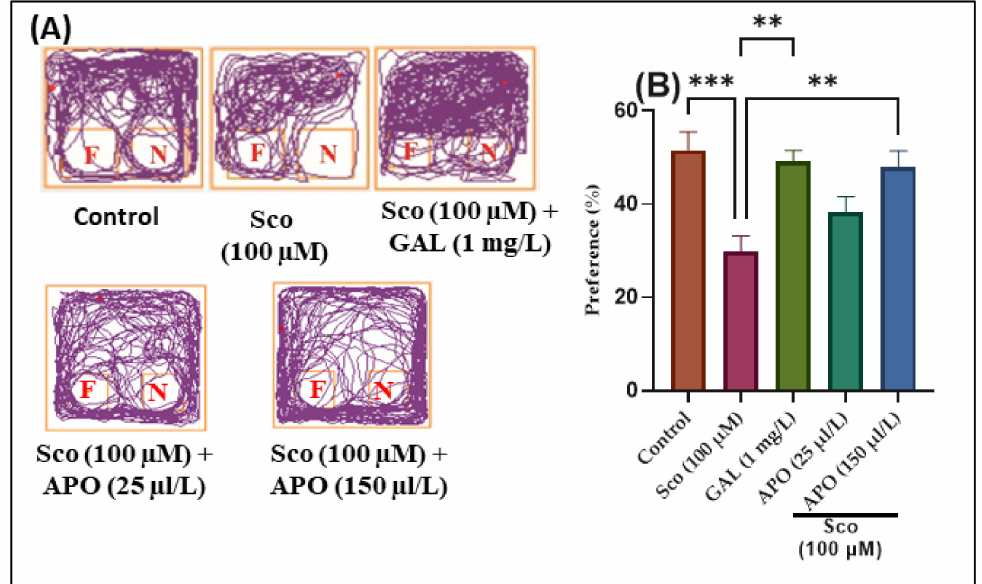
Figure 3. NOR results for Angelica purpurascens essential oil (APO: 25 and 150 µ L/L) ( A ) Representa- tive locomotion tracking patterns; ( B ) Preference (%). Data are presented as means ± S.E.M. ( n = 10). ** p < 0.001 and *** p < 0.0001 (Tukey’s post hoc analyses). Galantamine (GAL, 1 mg/L) was used as reference positive